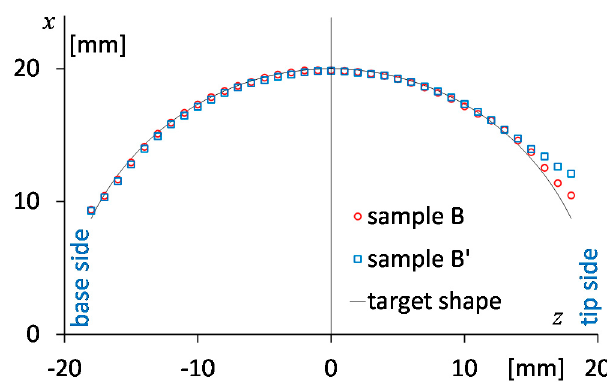
Figure 14. Profiles of the inner curves of samples B (red) and B’ (blue). The thin solid line corresponds to the target shape. The horizontal axis represents the axial distance from the middle cross section perpendicular to the spindle axis. The origin (0,0) is at the center of the target curvature.